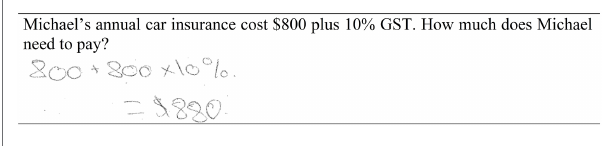
FIGURE 4 | A solution of a percentage increased problem that shows step skipping